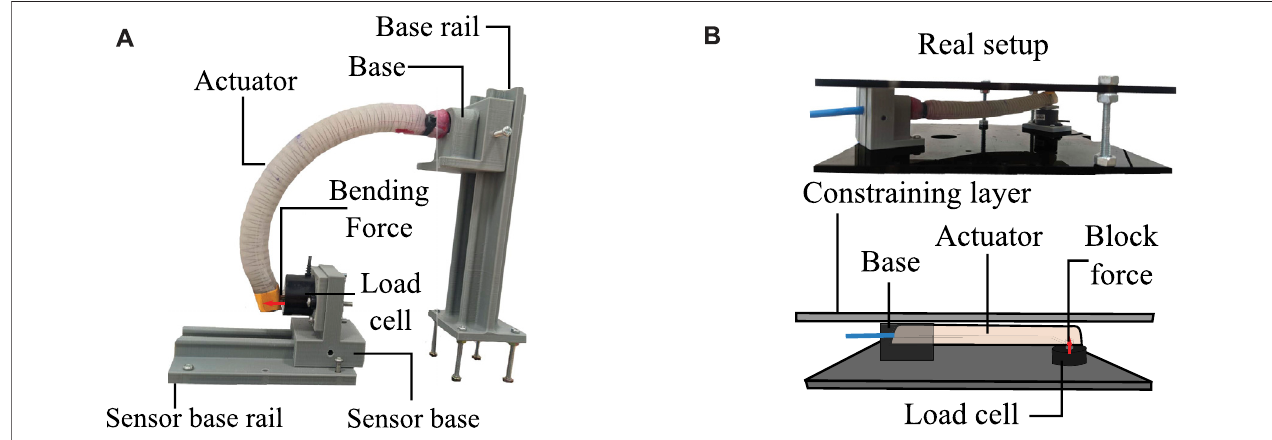
FIGURE5| Testofforceexertedbytheactuators. (A) Con fi gurationforbendingforcemeasurement.Itcanbeseenhowtheclampingsystemofthesensorandthe actuatorcanmodifyitslocationthroughrailstoadjustthetipoftheactuatorwiththeloadcell. (B) Con fi gurationforblockedforcemeasurement.Theupperimageshows an actual image of the test. The lower image shows a graphical explanation showing the key elements of the